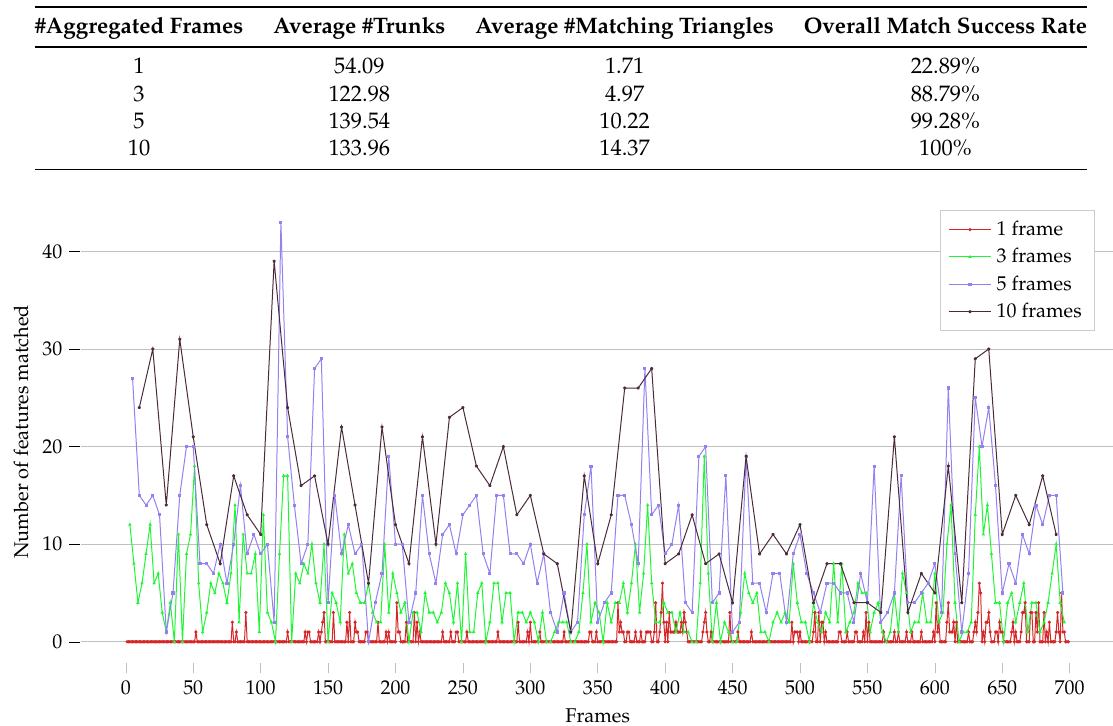
Figure 9. Number of features matched between G local and G map for different number of consecutive aggregated